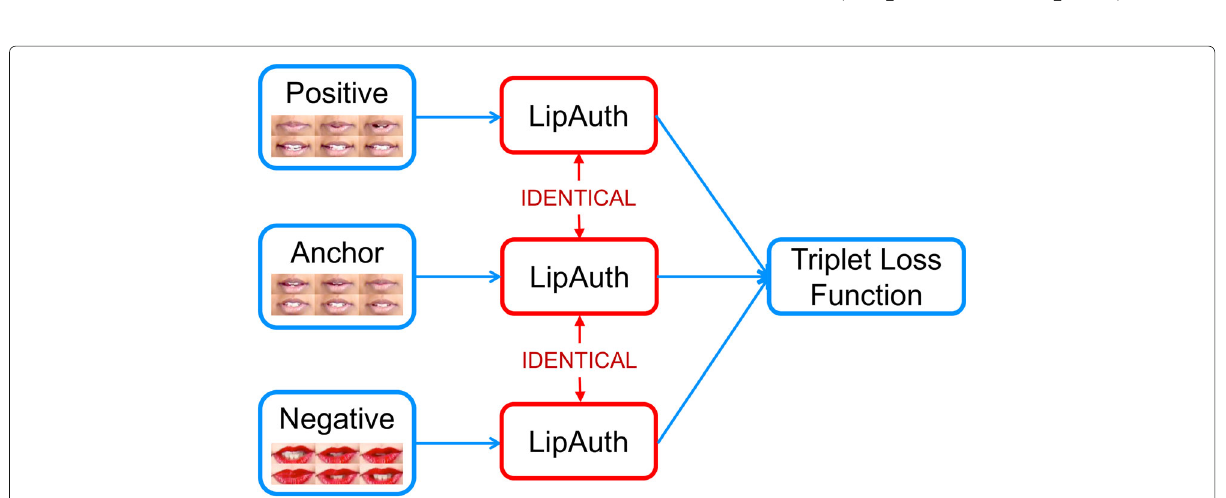
Fig. 2 LipAuth training overview. LipAuth was trained using a Siamese network architecture as shown here. Training data is organised in triplets, where each element of the triplet is passed to a branch containing an identical LipAuth model. The triplet loss updates the LipAuth weights identically in each